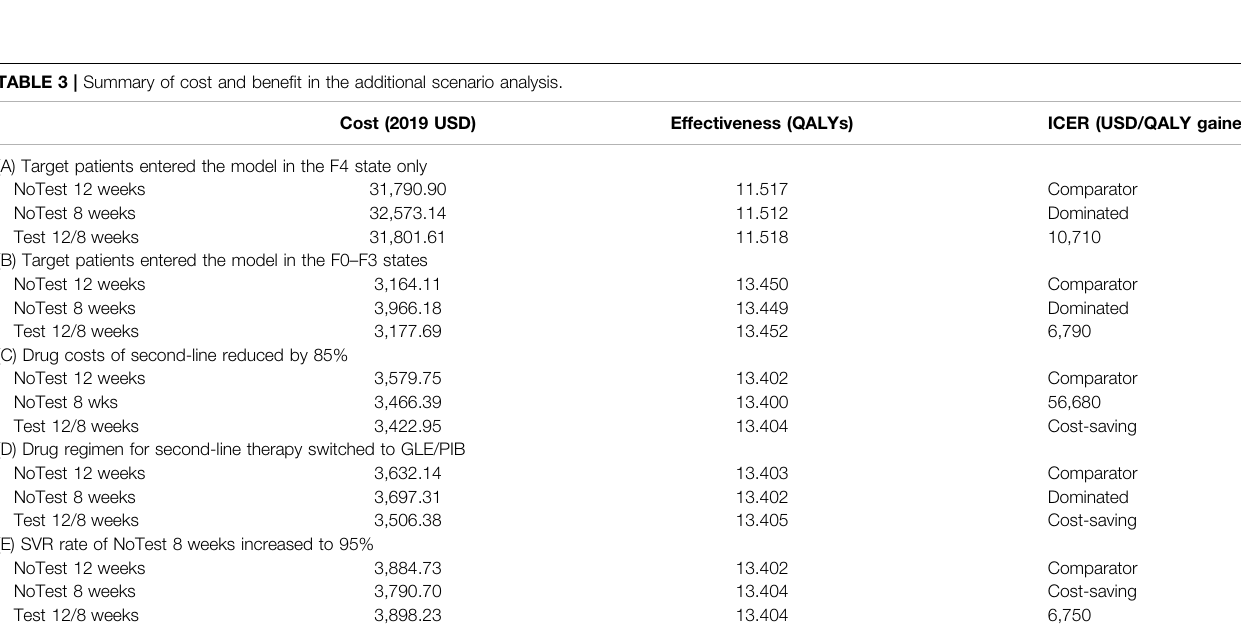
Frontiers in Pharmacology |